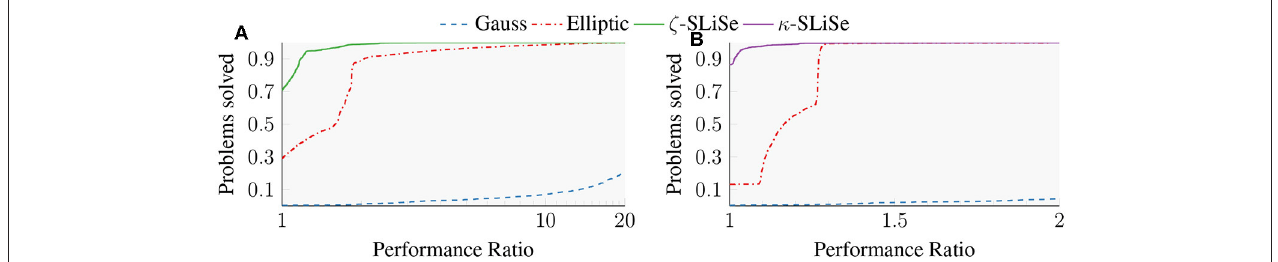
FIGURE 10 | Semi-log performance profile of the convergence rate for the Gauss, Elliptic, ζ -SLiSe, and κ -SLiSe filters. All filters have 16 poles and p = m . The last two filters violate Guideline 1. (A) Performance Profile of the Gauss, Elliptic, and ζ -SLiSe filters. (B) Performance Profile of the Gauss, Elliptic, and κ -SLiSe filters.